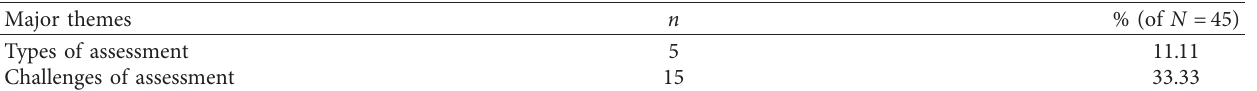
Table 11: Major themes identified for assessment practices in emergency remote teaching during COVID-19.